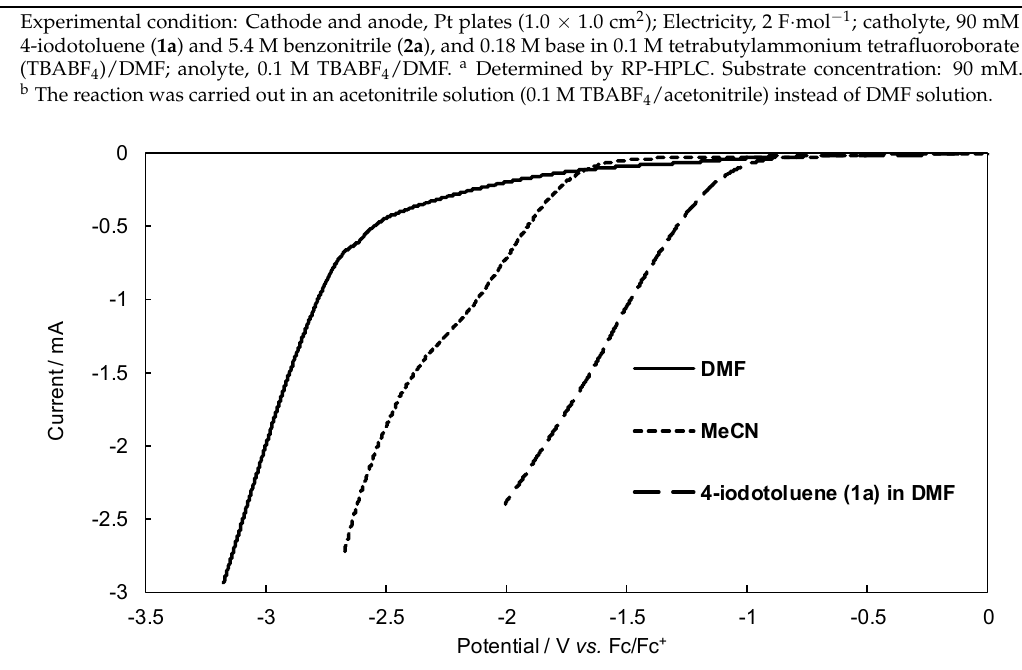
Figure 4. Linear sweep voltammograms of DMF electrolytic solutions with and without 1a , and acetonitrile electrolytic solution without 1a at a scan rate of 0.1 V·s − 1 .